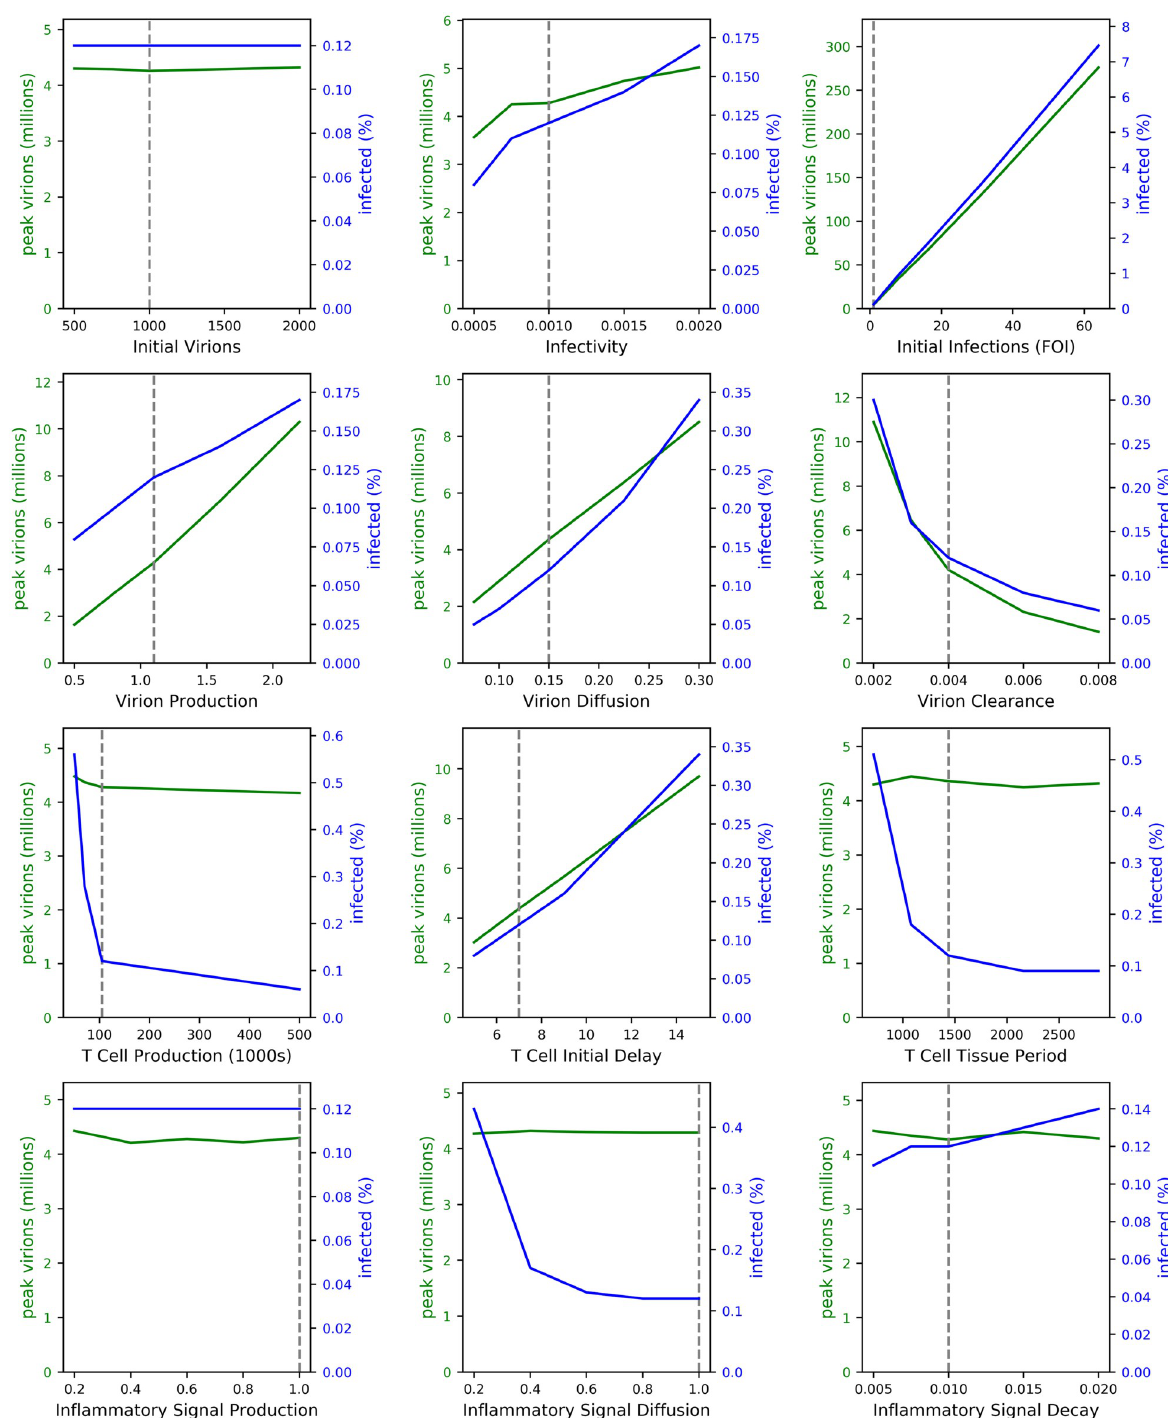
Fig 5. The effect of varying model parameters, one at a time. Each line is the average of five runs. Dashed lines indicate SIMCoV default values. The left axes (green lines) show how each parameter affects peak viral load and the right axes (blue lines) show the effect on the percent of cells in the simulation that become infected. The one-at-a-time sensitivity analysis is detailed in Materials and Methods.